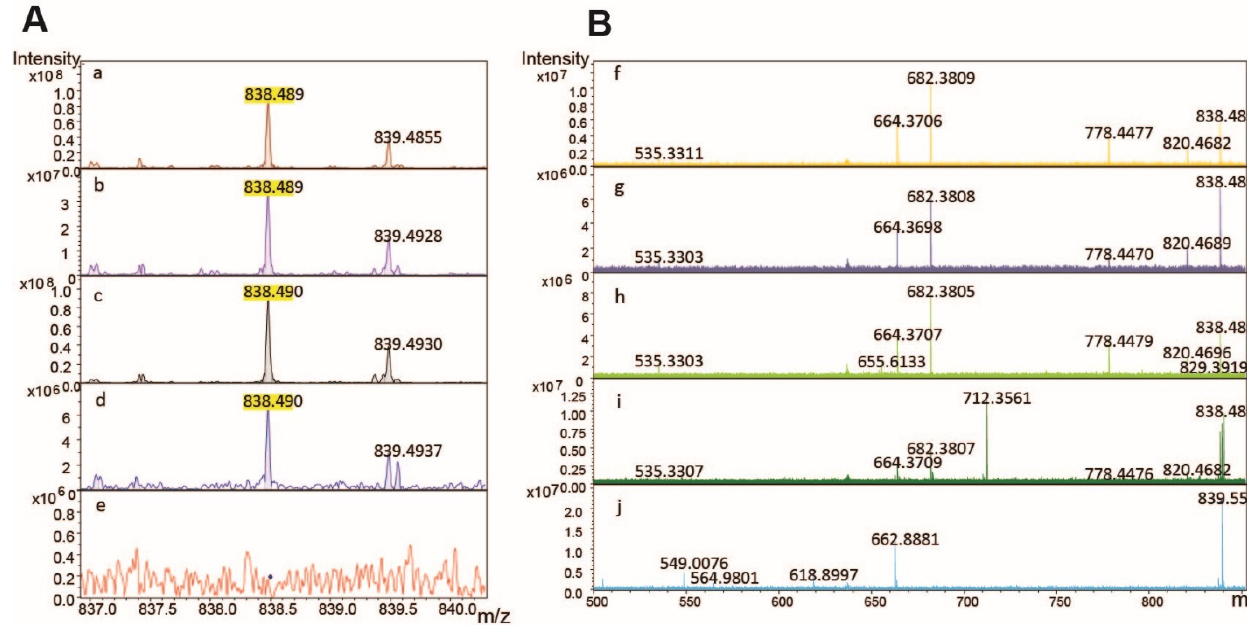
Figure 4. ( A )( a – e ): MALDI-FTICR MS spectra for the detection of the TGFBIp digest at m / z 838.489 (peptide